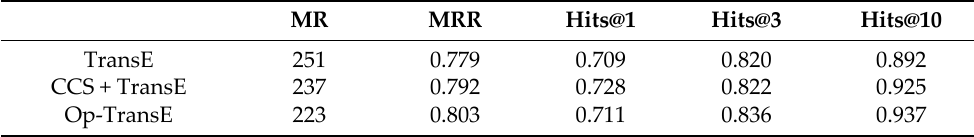
Table 7. Experimental results on the WN18 compared with the TransE model.